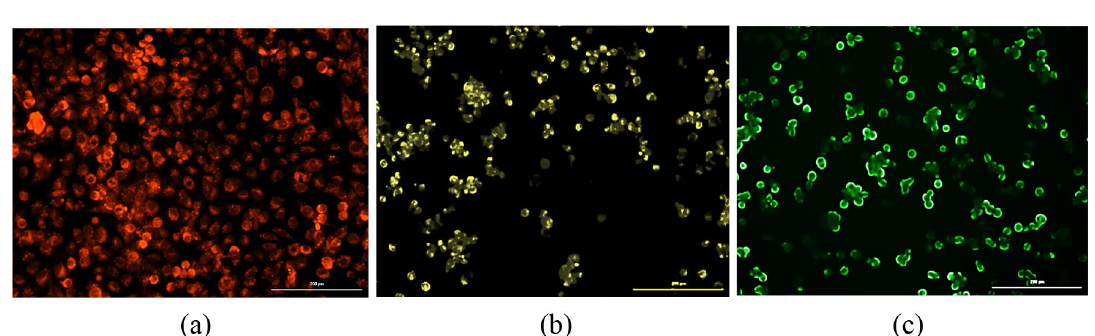
Figure 8. Assay of A375 cells mitochondrial membrane potential with JC-1 as fluorescence probe staining method for 24 h. ( a ) Control, ( b ) C1, and ( c )